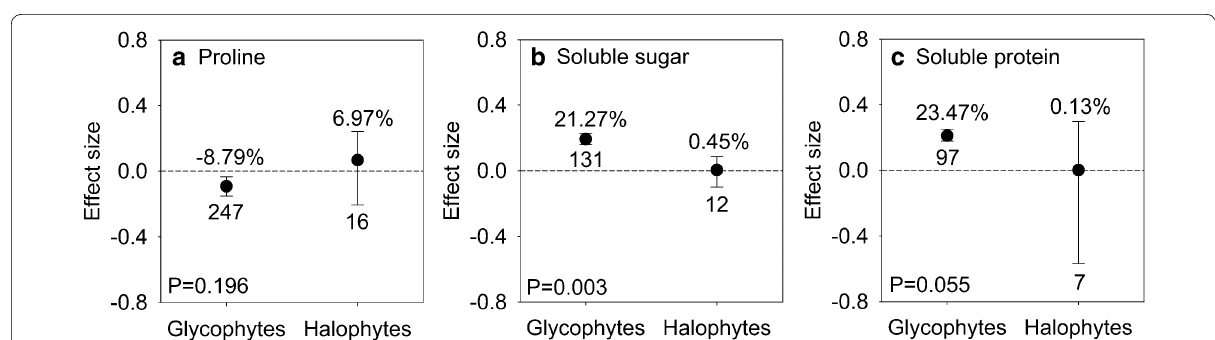
Fig. 2 Responses to salt stress of proline ( a ), soluble sugar ( b ) and soluble protein ( c ) in mycorrhizal halophytes and mycorrhizal glycophytes. Error bars represent 95% confidence intervals (CIs). Back-transformed effect sizes are shown above the bars. The numbers of studies are shown under the bars. Inoculation effects were considered significant when the 95% CIs did not overlap with zero. The P values for each panel reflect the significant differences between halophytes and